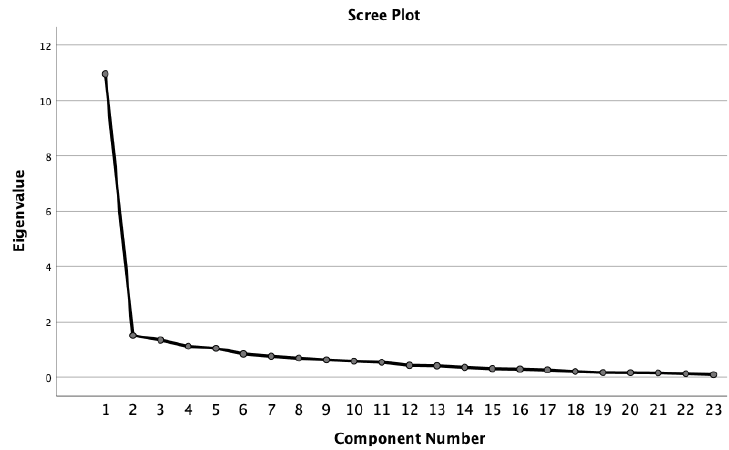
Figure 1. Scree plot representing the eigenvalues (23-item Resilience Scale). Table 6. Descriptive statistics, Cronbach’s alpha coefficient of RS models, and EFA assessment of These solutions were further investigated when removing item 10 due to low pattern normality of coefficients (<0.40) (Table 4) and led to the further analysis of the 21-item structure of the RS. The assessment of the KMO (0.90) and Bartlett’s Test of Sphericity ( χ 2 = 1514.725, df = 210, p < 0.001) allowed us to proceed with an EFA. A PCA with Varimax rotation and scree plot analysis presented a four-factor solution with a cumulative explained variance of 68.17%, which was higher than the percentage obtained with the previously analyzed structures (Table 3). At this stage, the 21-item scale included Factor 1 (items 5, 6, 12, 13, 14, and 19), Factor 2 (items 1, 2, 3, 4, and 11), Factor 3 (items 7, 8, 15, 16, 17, and 22), and Factor 4 (items 9, 20, 21, and 23) (Table 4). Factor 1 was labeled “The meaning of life”, Factor 2 “Self-reliance”, Factor 3 “Self-confidence”, and Factor 4 “Acceptance of Life circumstances”. Internal consistency of the overall 21-item scale (0.95) would not significantly improve with the deletion of any observed variable, and as such no other item was deleted (Table 6).